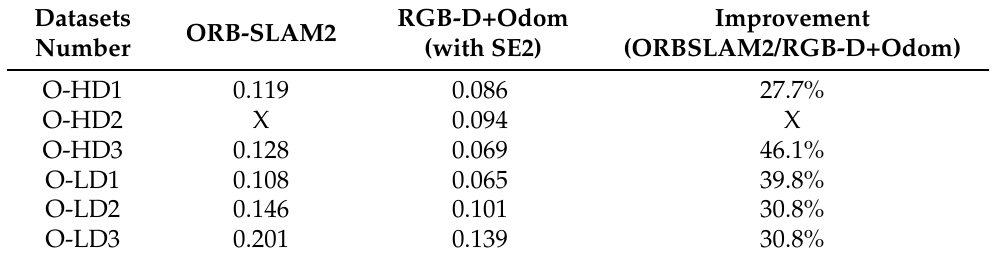
Figure 7. Positioning results of ORBSLAM2 and the proposed fusion positioning system. Table 1. Positioning accuracy comparison between ORBSLAM2 and ours (unit: m).